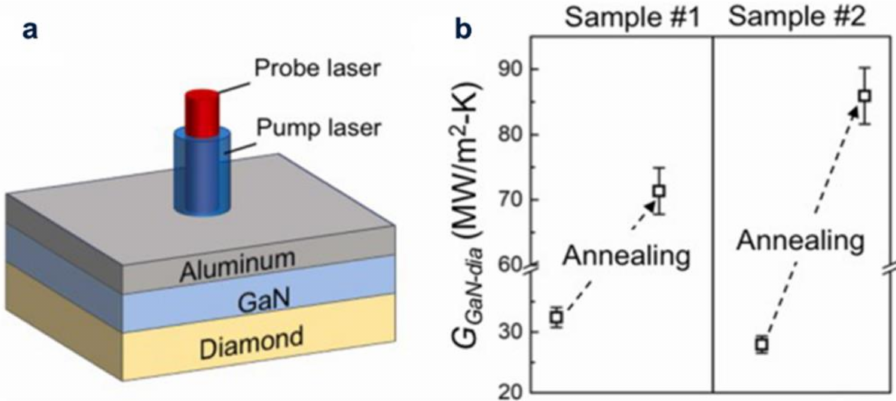
Figure 4. ( a ) The diagram of GaN/Al/diamond structure fathomed by TDTR, ( b ) The diagram thermal boundary conductance of diamond contact face (GGaN-dia)/GaN fathomed by